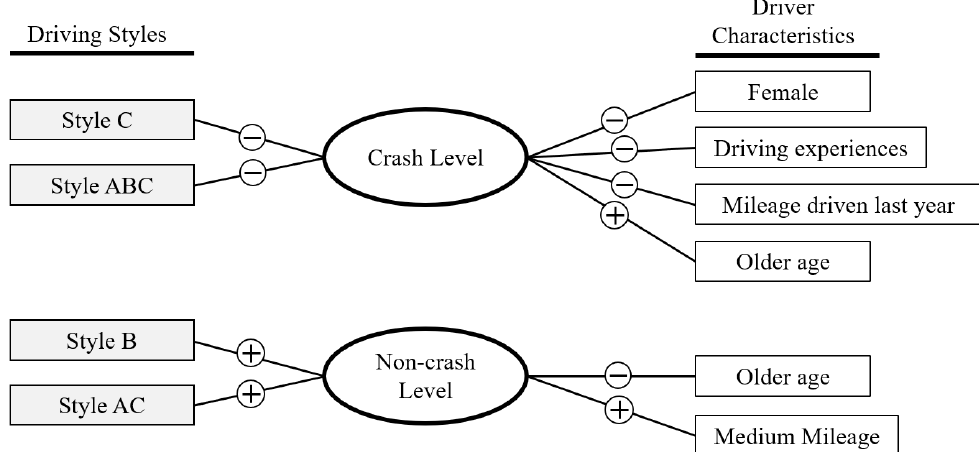
Figure 1. Illustration of modeling results with significant driver level characteristics. Negative signs indicate negative association and positive signs indicate positive association.